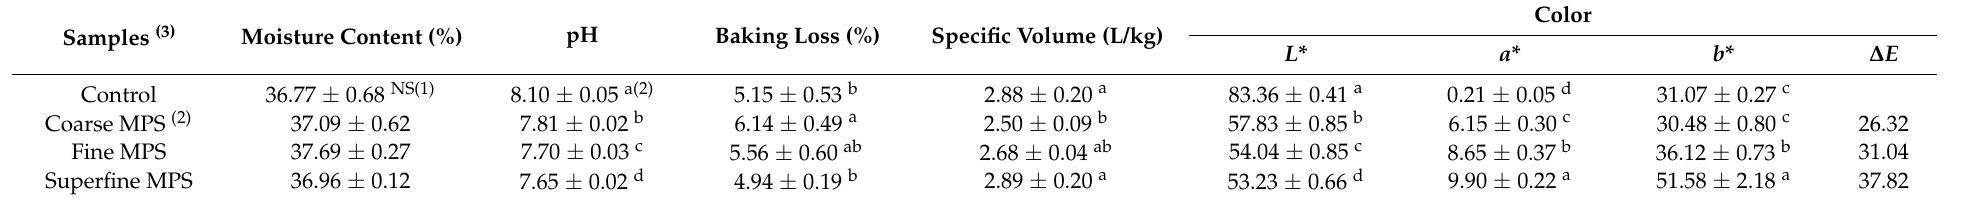
Table 3. Physical properties of sponge cake prepared with differently sized